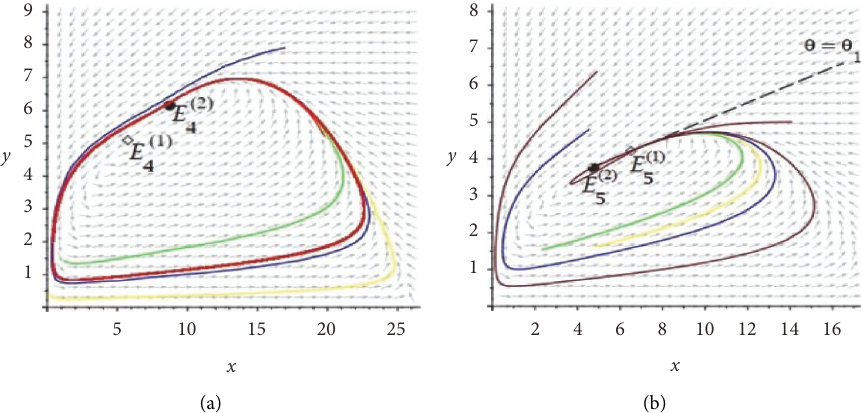
of codimension 2 and a stable node 5